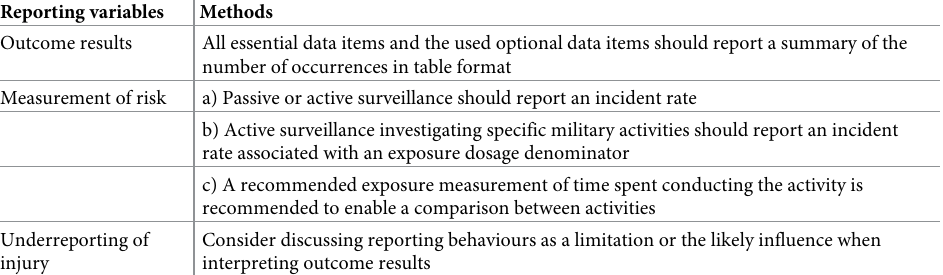
Table 5. The recommended outcome reporting for all surveillance based upon the outcomes of the Delphi consen- sus